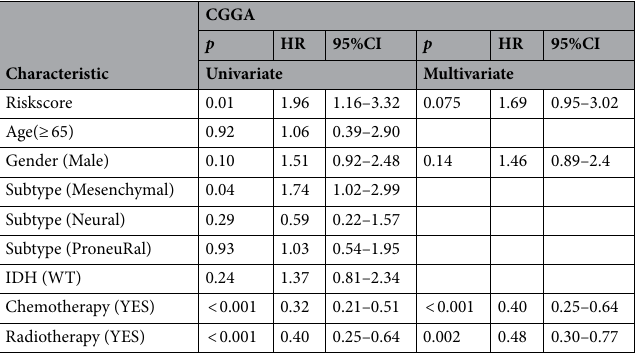
Table 3. Univariate and multivariate cox proportional hazards analysis of clinicopathological variables and hypoxia signature based on OS in the CGGA GBM validation